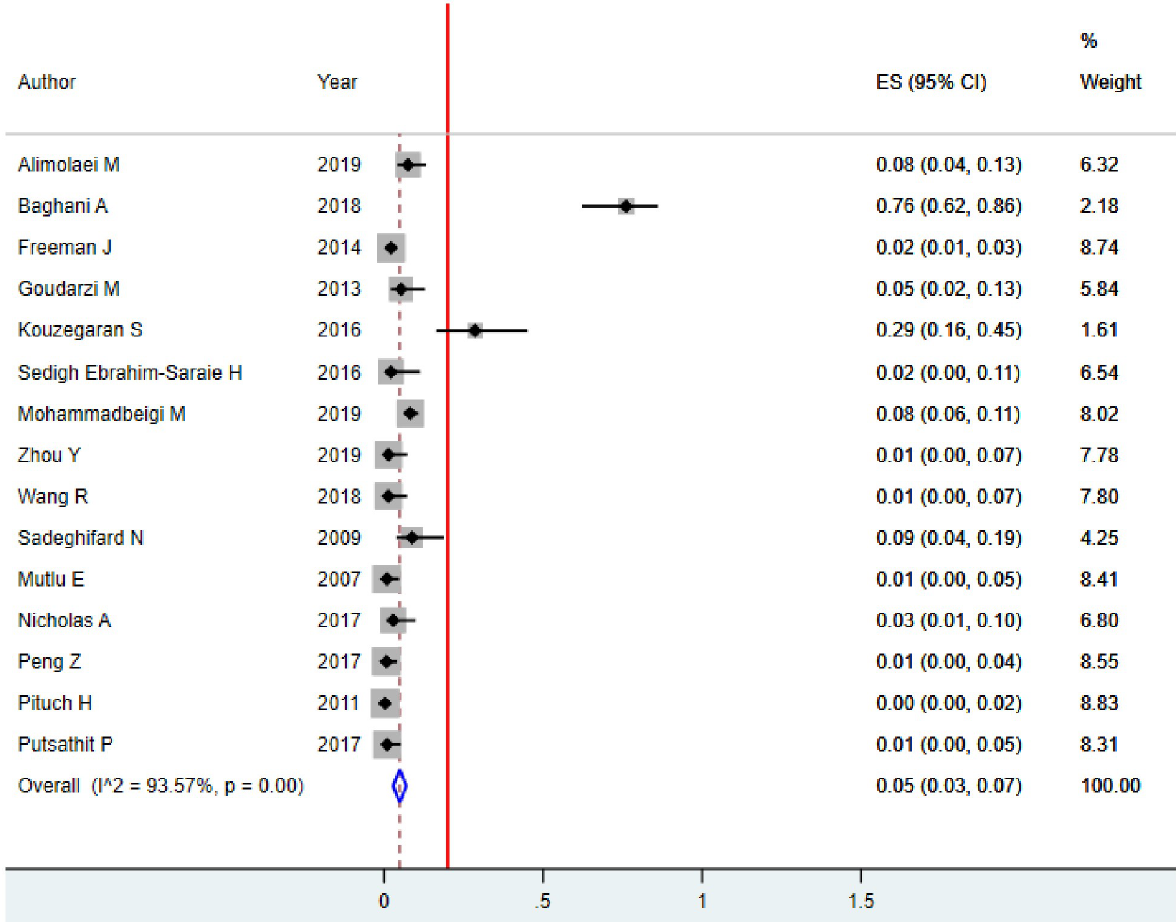
Fig 7. Pooled proportion of metronidazole resistance of C . difficile among hospitalized diarrheal patients.